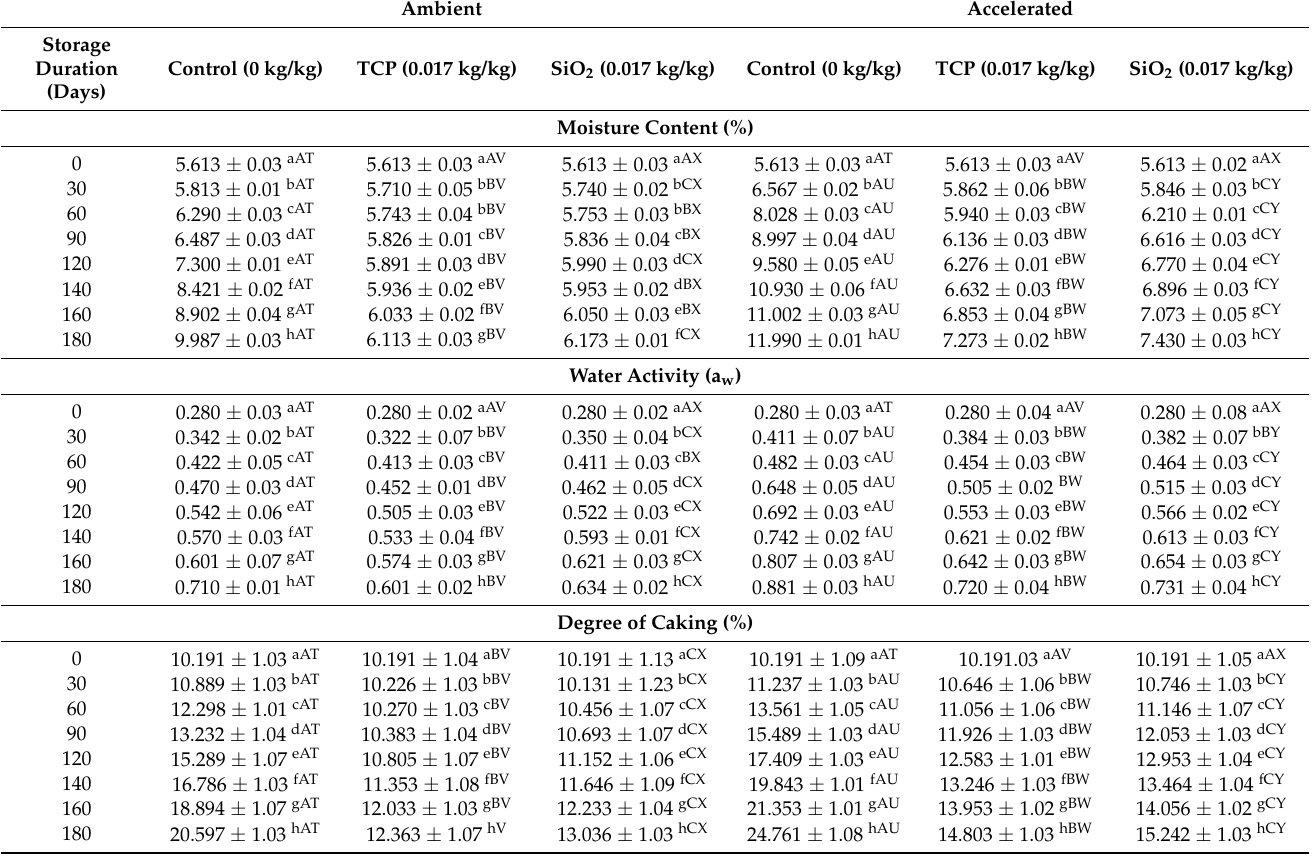
Table 1. Effect of storage duration, storage conditions (ambient and accelerated), and anticaking agents (TCP and SiO 2 ) on moisture content, water activity, and degree of caking of spray-dried apricot powder